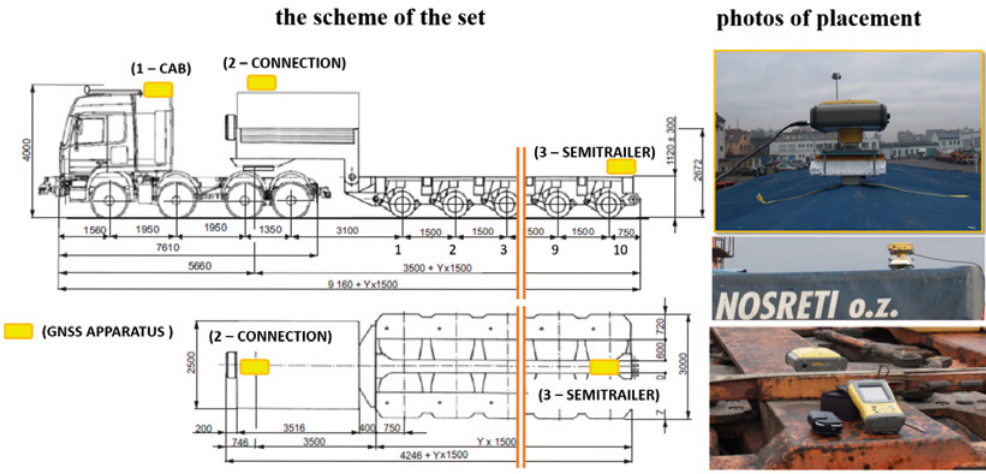
Note: measurements in Figure 1. Placement of Global Navigation Satellite System apparatus on the set